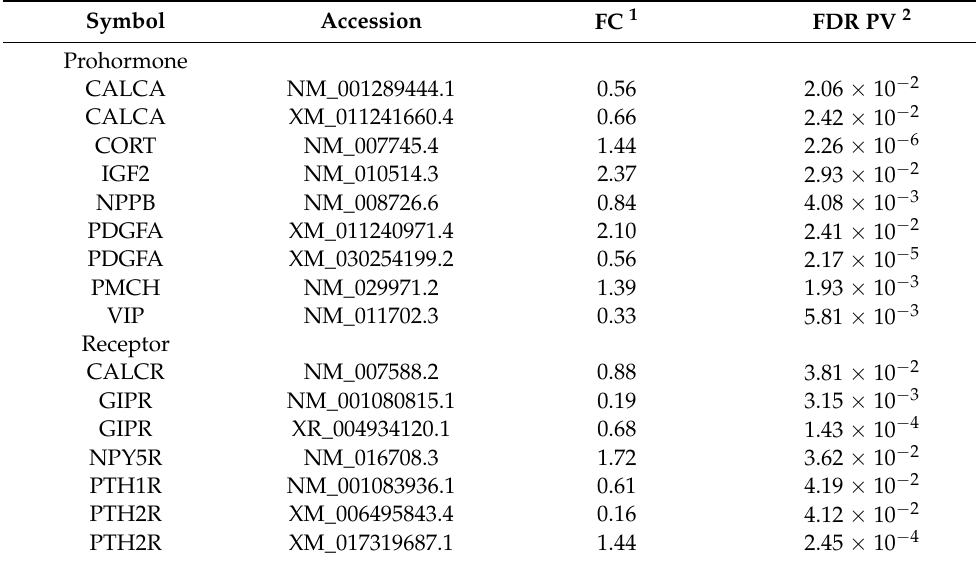
1 FC = fold change. Treatment fold change for nitroglycerin-elicited hyperalgesia compared to control; 2 PV = FDR- adjusted p -value.